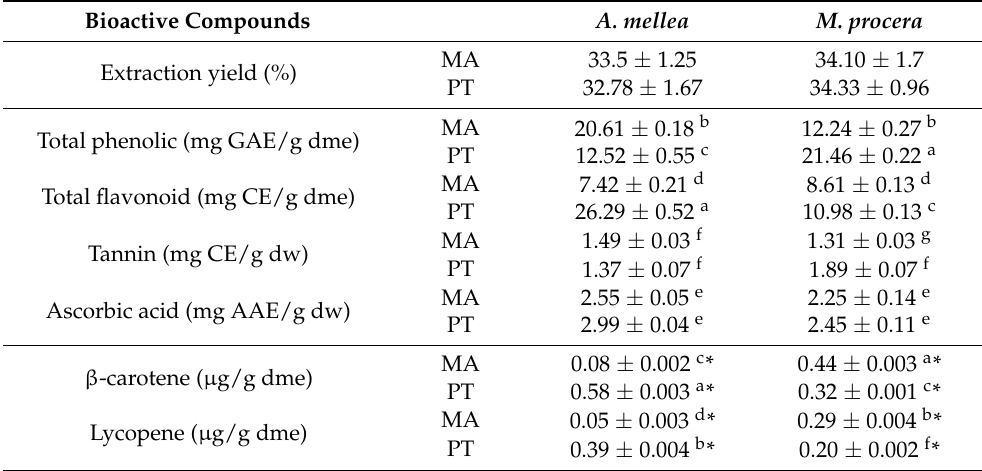
studies 1 . Bioactive